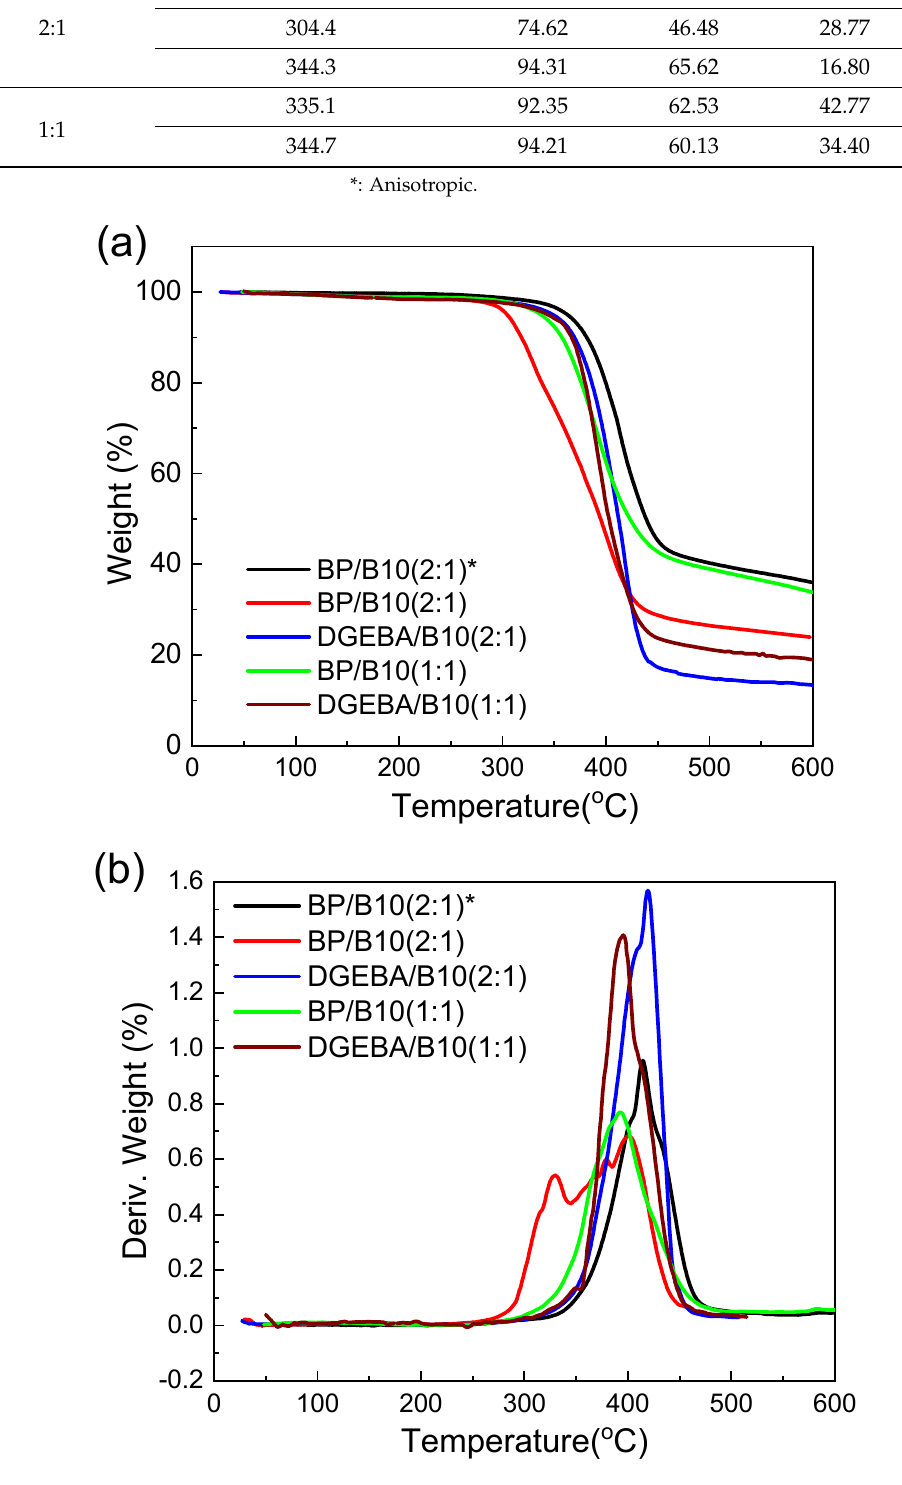
Figure 4. ( a ) Thermogravimetric analysis of cyanate ester (B10)-cured epoxy resin, ( b ) derivative weight versus temperatures of B10-cured epoxy resin (*: anisotropic).